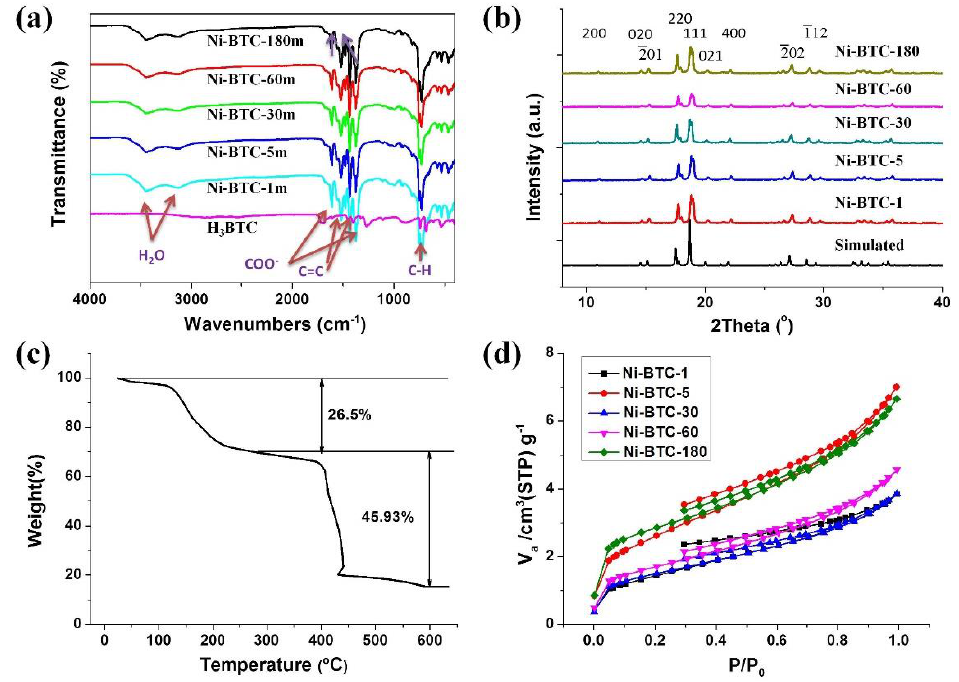
Figure 2. Characterizations of the Ni-BTC samples obtained at various reaction times. ( a ) FTIR spectra, ( b ) XRD patterns, ( c ) TGA curve of Ni-BTC-1m, and ( d ) Nitrogen adsorption and desorption.